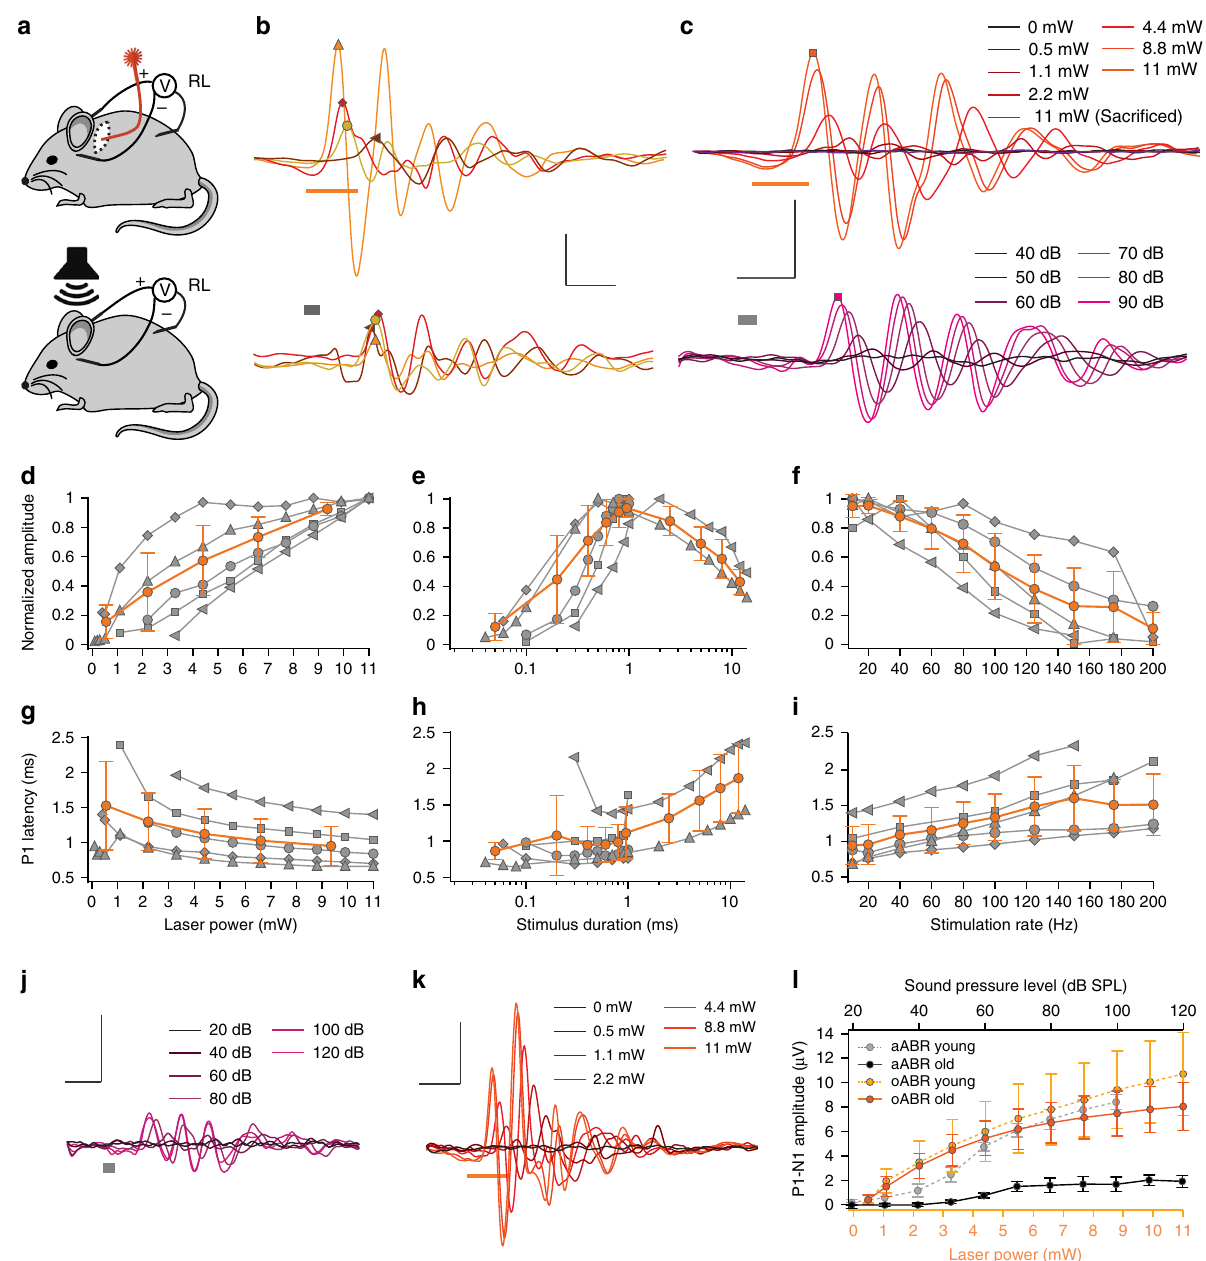
Fig. 5 Single-channel oCIs drive oABRs in hearing and deaf mice. a Experimental set-up for oABR-recordings in mice: a 50 µ m optical fi ber coupled to a 594 nm Obis laser was implanted into scala tympani via a posterior tympanotomy and the round window. Recordings of far- fi eld optically evoked potentials were performed by intradermal needle electrodes. For aABR recordings a free- fi eld speaker was employed (lower panel). b Comparing oABRs (upper panel) and aABRs (lower panel) at strong stimulation levels for four mice (average of 1000 trials). oABRs were recorded in response to 1 ms long, 11 mW, 594 nm laser pulse at 10 Hz, aABRs of the same mice in response to 80 dB (SPL peak equivalent) clicks. Bars indicate the stimulus timing. c oABRs (upper panel, 594 nm, 1 ms at 10 s -1 ) and aABRs (lower panel, clicks at 10 s -1 , values in SPL [peak equivalent]) recorded from an exemplary AAV-injected mouse at increasing stimulus intensities. d – f Normalized P1-N1-amplitude as a function of laser intensity ( d 1 ms at 20 Hz), pulse duration ( e 11 mW at 20 Hz), and stimulus rate ( f 11 mW, 1 ms). Group average (lines) and s.d. (error bars) are shown in orange (same for g – i ). g – i P1-latency as a function of laser intensity ( g as in d ), duration ( h as in e ), and rate ( i as in f ). j Exemplary aABR recordings done as in a – c using a 9 months-old mouse (following postnatal AAV- Chrimson-EYFP injection: elevated acoustic thresholds (around 60 dB [SPL], compare to c ). k oABR recordings done as in a – c in the same mouse as in j , using 1 ms long laser pulses: thresholds similar to injected mice at 2 – 3 months of age (around 1 mW, compare to c ). l P1-N1-amplitude of oABR (orange) and P1-N1-amplitude of aABR (gray) as function of stimulus intensity in young (2 – 3 months-old) and old (9 months-old) mice ( n = 5 for each group, means (lines) ± s.e.m. (error bars) are shown. Symbols in d – i mark results from individual animals. Scale bars ( b , c , j , k ): 1 ms, 5 µ